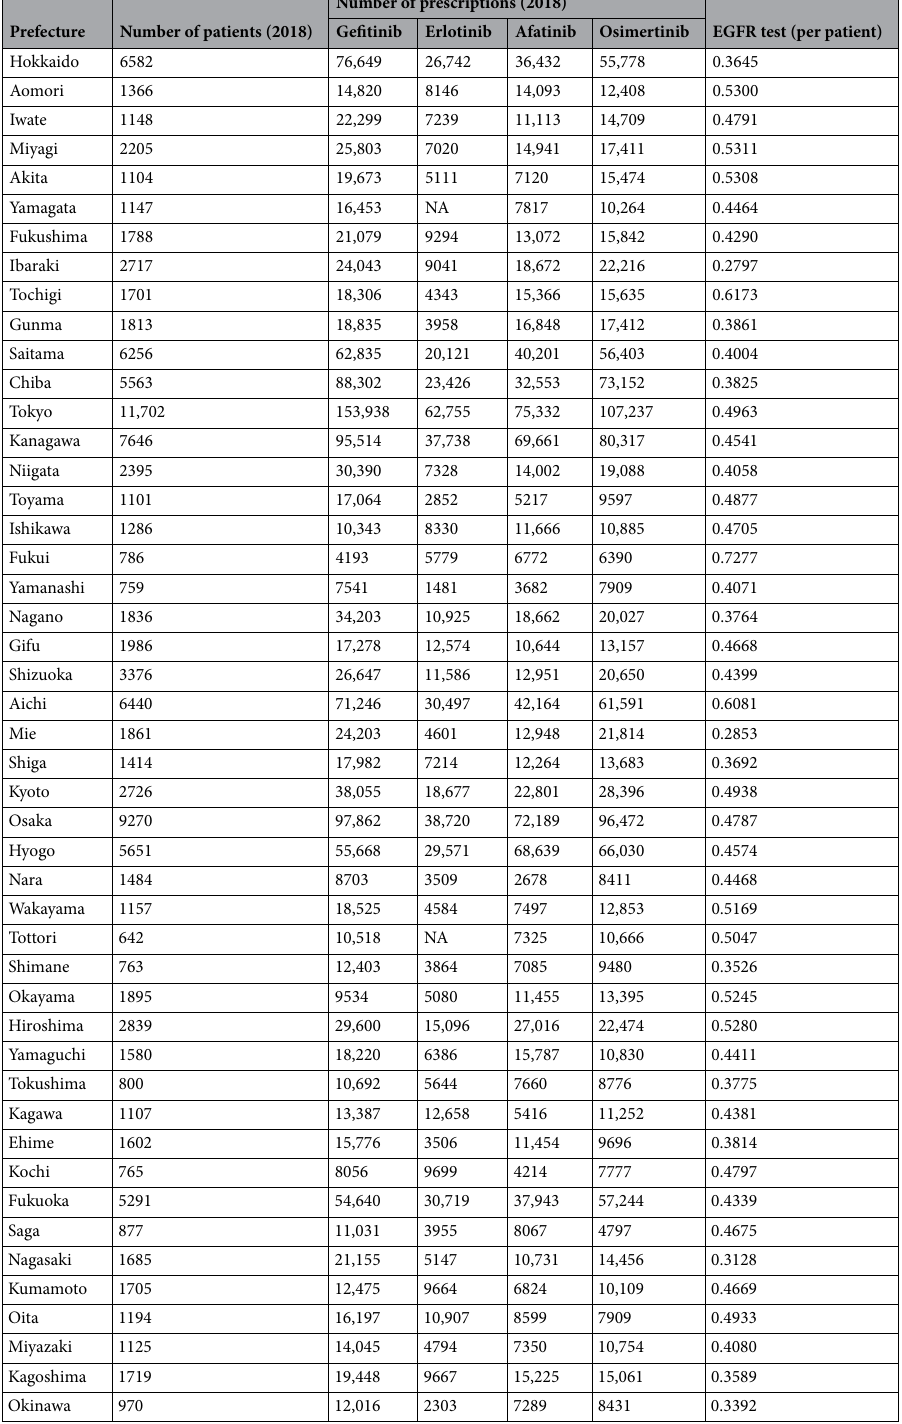
Table 1. Numbers of patients and prescribed drugs in each prefecture. EGFR Epithelial growth factor